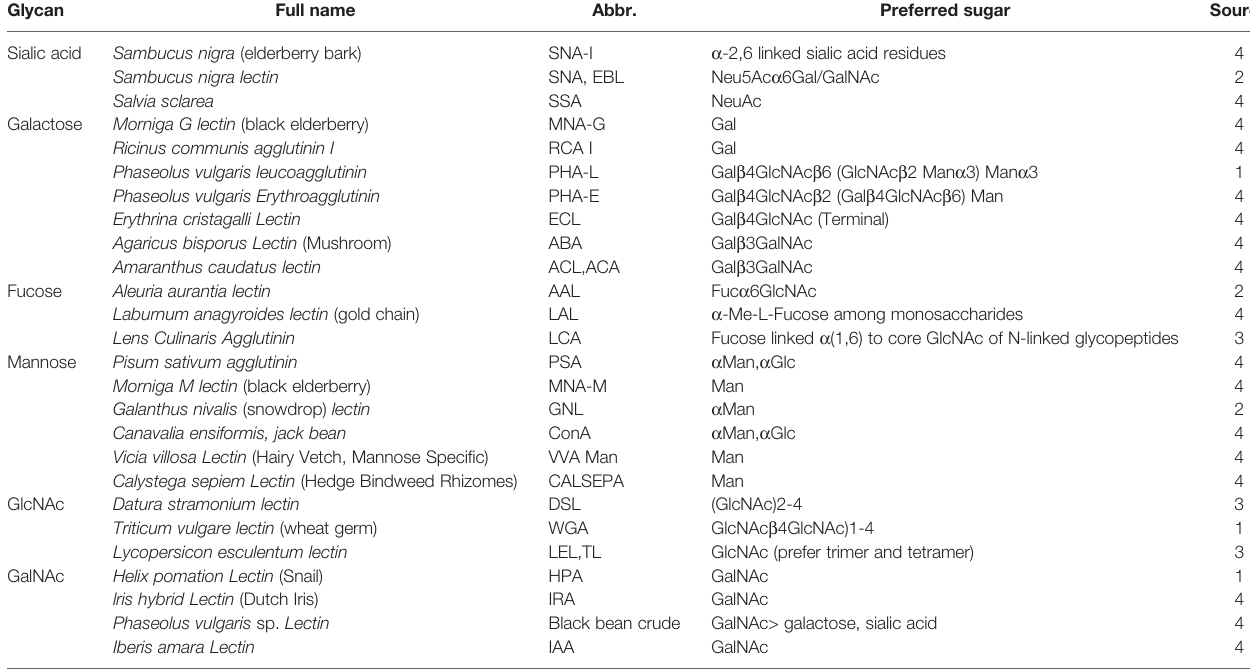
TABLE 3 | The recognition speci fi city and source of lectin. Glycan